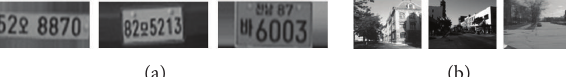
Figure 5: Positive sample images of Korean LPs.